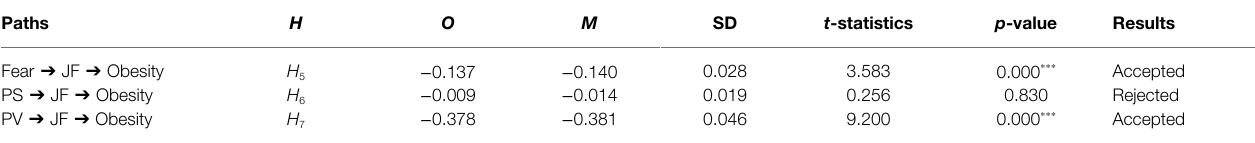
TABLE 6 | Indirect effects.